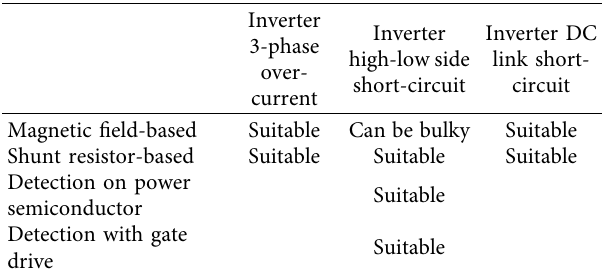
Figure 13: Over-current detection using gate drive output current pulse peak. Table 1: Over-current detecting locations.